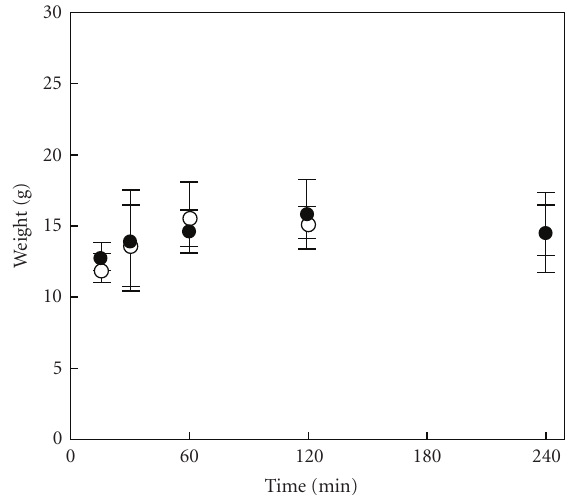
Figure 2: Change in hardness of hydrogel beads (mean ± S.D., n = 5). Open circles: Alg-Ca; closed circles: CAP (0.8% AP).